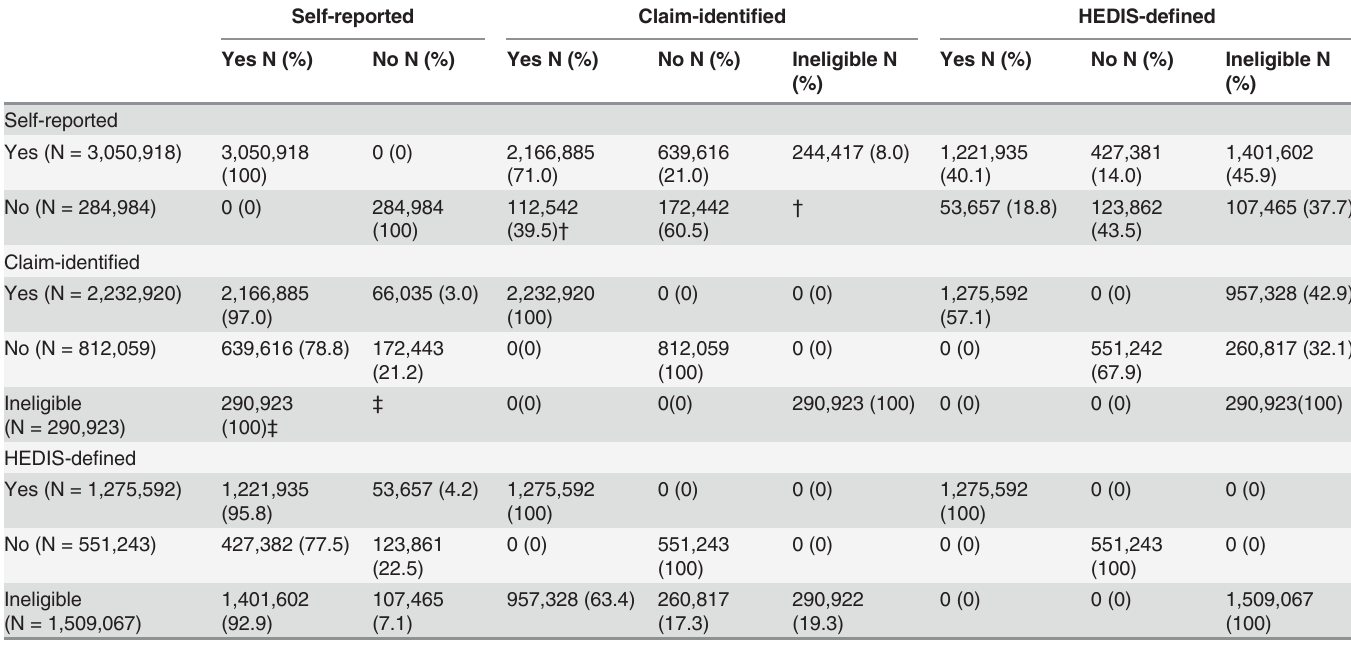
Table 2. Agreement of self-reported versus claim-identified versus HEDIS-defined sexual activity among annual 3.3 million Medicaid women aged 18 – 25 Years (N = 338), 2001 – 2004.